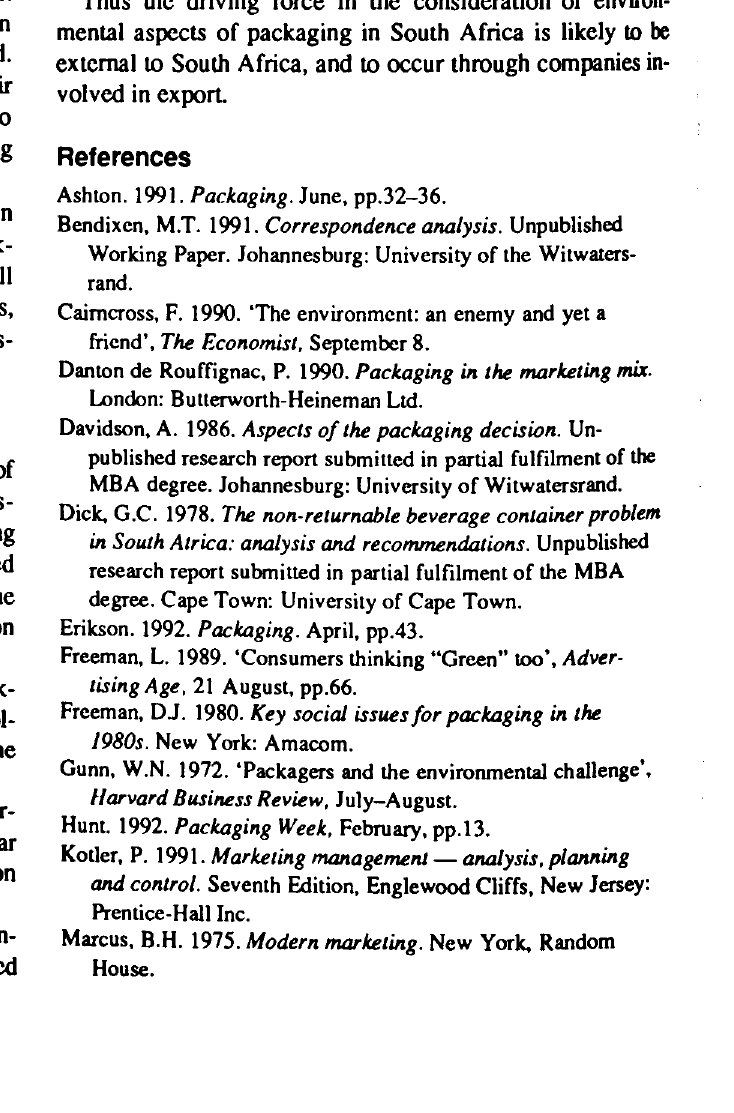
Figure 3 Correspondence plot of packaging attributes Visual comparison illustrates the differences between the South African and American responses. Concern for dispos ability of packages is shown by the majority of